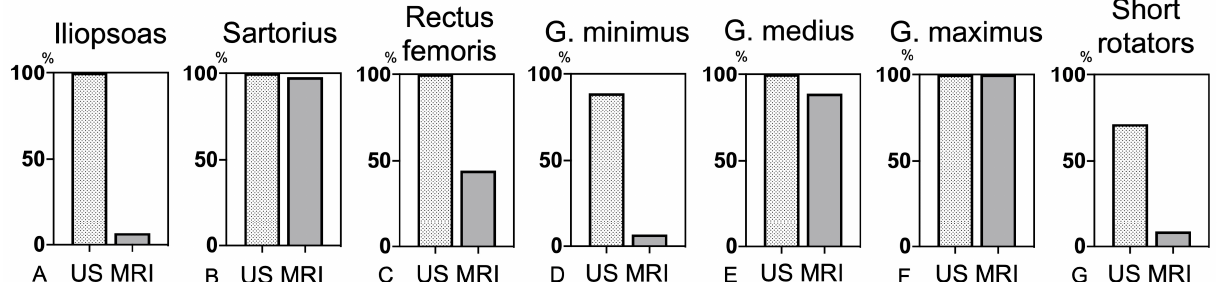
Figure 6. Visibility of periprosthetic muscles in the study cohort by ultrasonography and magnetic resonance image. In the anterior part, the iliopsoas, sartorius, and rectus femoris were detectable by MRI in 6.7%, 97.8%, and 44.4% of the HRA cases, although ultrasonography showed 100% of visibility of all these muscles ( A – C ). In the lateral part, the gluteus minimus and medius could be detected in 6.7% and 88.9% of the patients by MRI, and in 88.9% and 100% of these cases by ultrasonography ( D , E ). The gluteus maximus and short rotators were detectable in 100% and 8.8% of the patients by MRI and 100% and 71.4% of the patients by ultrasonography ( F , G ).